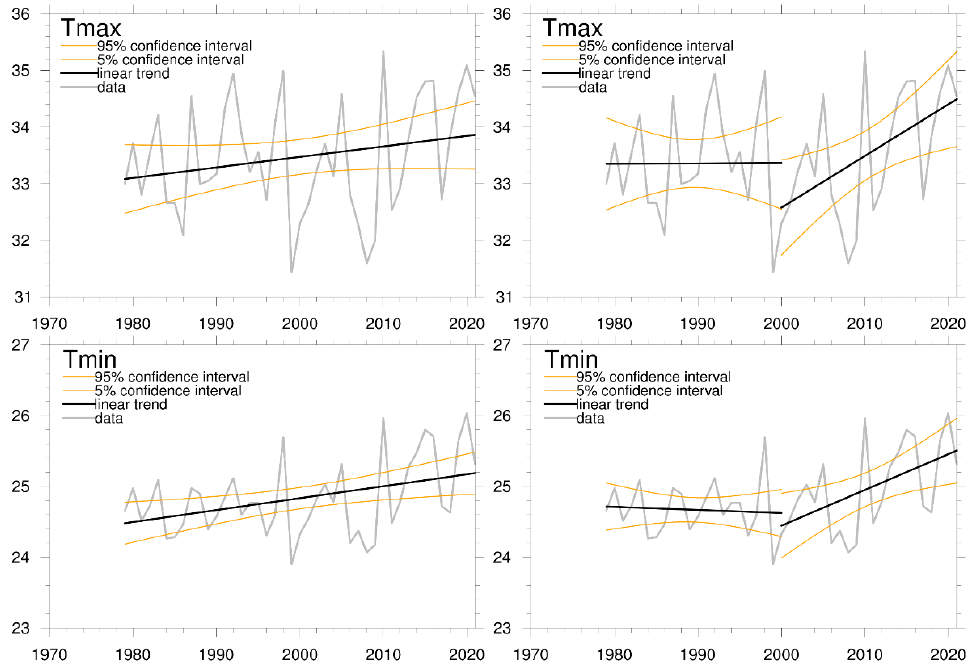
Figure A1. The linear trends of monthly Tmax and Tmin of May for the periods ( left ) 1979 – 2021 and ( right ) 1979 – 2000 and 2000 – 2021.